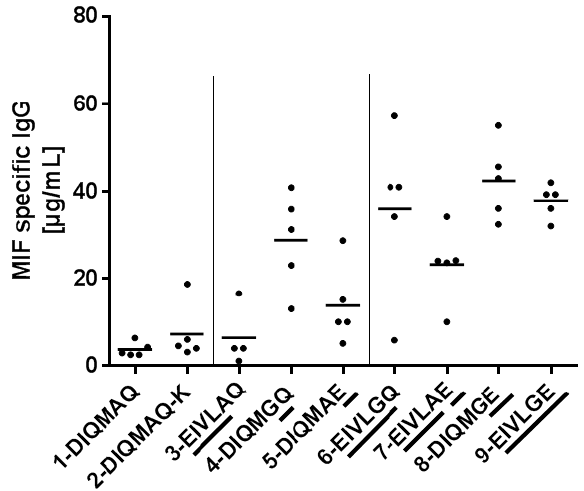
Figure 3. Macrophage migration inhibitory factor (MIF)-specific IgG titer of BaxM159 variants. MIF-specific IgG titer was determined by ELISA. BaxM159 variants were grown to ml scale starting with an initial cell number of 0.3 – 0.5 × 10 6 cell/mL. At day 7 – 8 of cell cultivation MIF-specific IgG titer was determined from cell culture supernatant by ELISA. In total, five independent expression experiments were conducted. Statistical analysis is given in the Supplement Table S1.